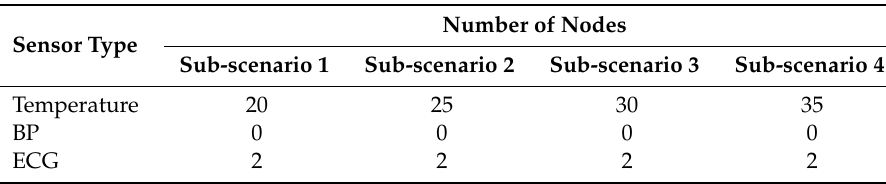
Table 4. Deployment of sensors in Scenario